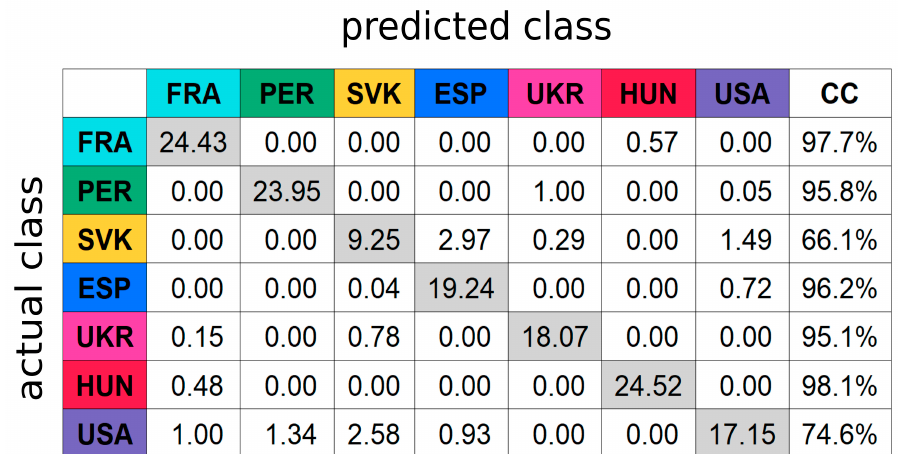
Figure 4. Mean Random Forest (RF) classification matrix using peak areas of 20 marker substances (after pareto scaling). The confusion values were given as average of 100 repeats of 10-fold cross- validation (CV) along with correct classification (CC) rates.